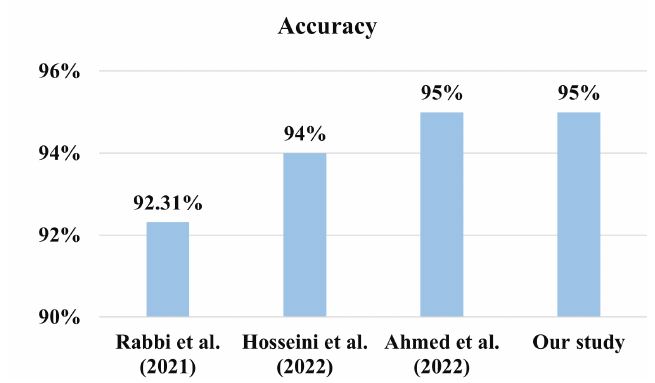
Figure 12. Graph illustrating the best accuracy on second dataset and compared with referenced literature